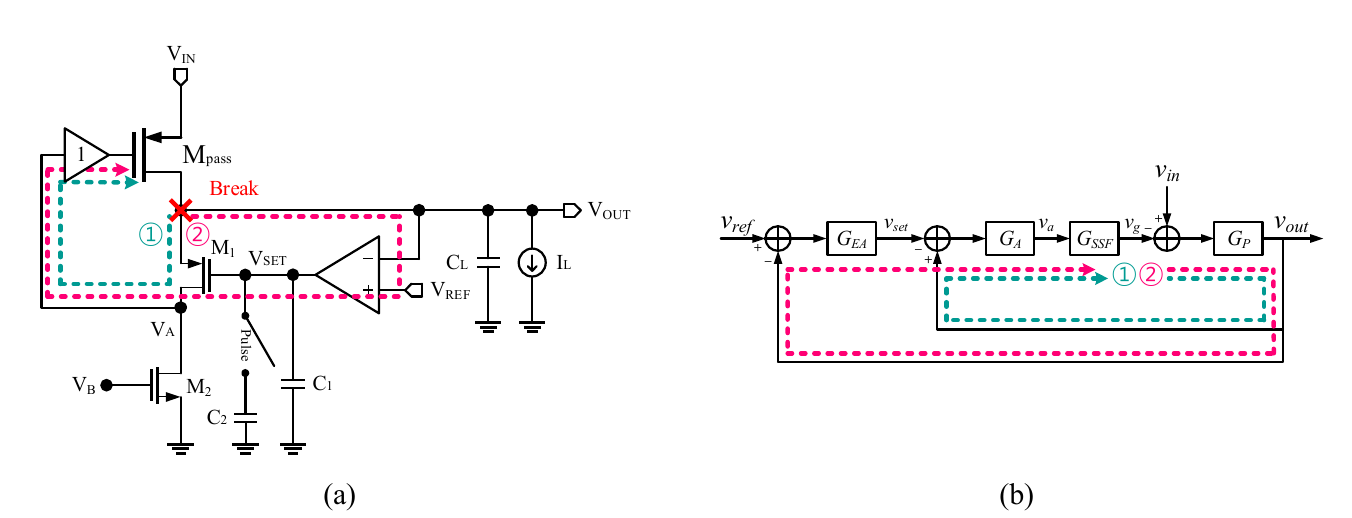
Figure 4. ( a ) Small-signal block diagram and ( b ) its simplified block diagram. Here, the open-loop gain had a dominant pole at the output of the EA, and the second pole was at the output of the LDO. The (1 + G EA ) term in (11) made a quadratic zero near the unity-gain bandwidth of the EA. This zero was set to cancel out the second pole, which was below the unity-gain bandwidth of the LDO. It was noted that the LDO would be unstable without this zero. As a result, the (1 + G EA ) term boosted the unity-gain bandwidth of the LDO. Figure 5 shows the phase margin simulation result. The unity-gain bandwidth of loop 1 was 507 MHz, and the phase margin was 37.3°. The unity-gain bandwidth of the loop 2 was 31.2 MHz, and the phase margin was 63.6°. The unity-gain bandwidth of the overall loop was 469 MHz, and the phase margin was 44.1°.